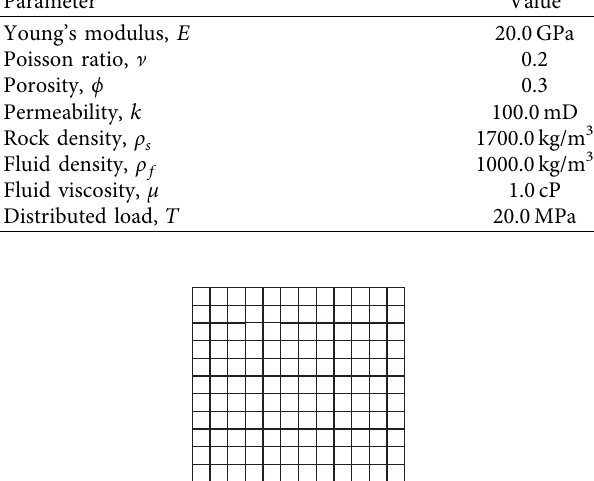
Figure 5: Diagram of Terzaghi’s problem.